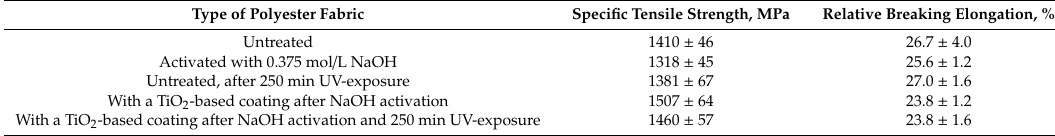
Table 4. The main physico-mechanical characteristics of a polyester fabric with TiO 2 nanoparticle